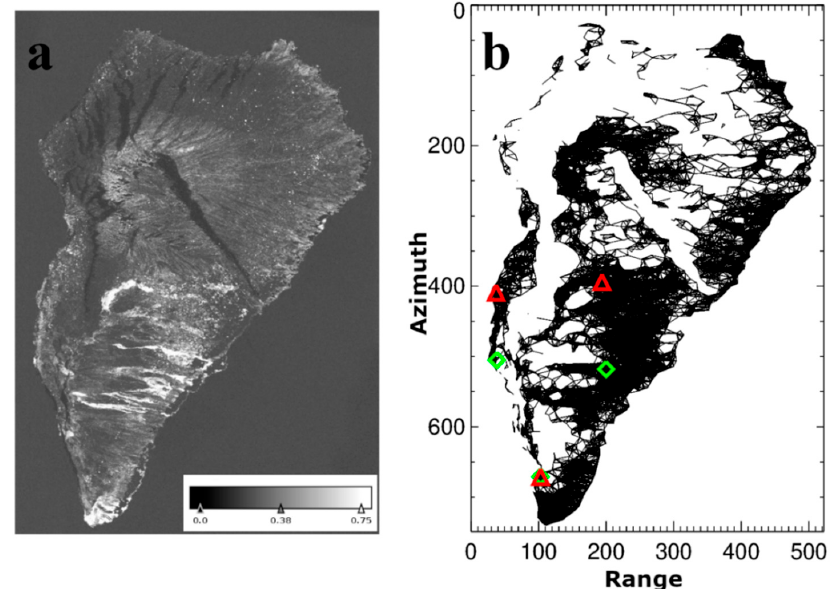
Figure 4. 3D GNSS displacement time series and adjusted linear fits for the JEDE station. This station was used as one of the velocity seeds with zero cm/year (in LOS projection) for A-DInSAR processing of descending orbit images. The red lines on the subfigures show the linear fit to the time series used to estimate the mean annual velocities.